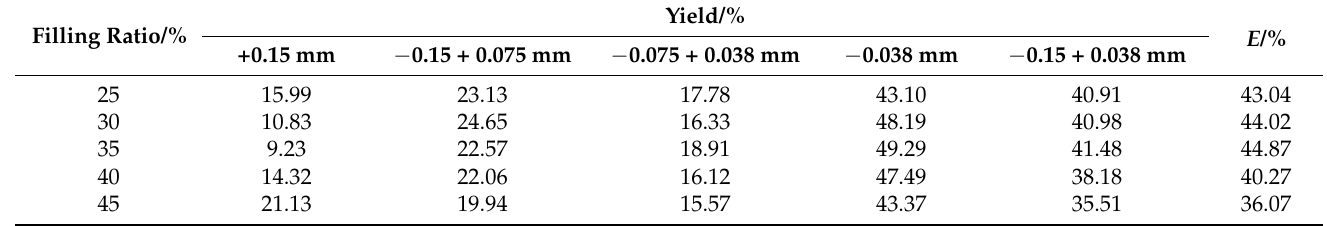
Table 6. Particle size composition of grinding product at different filling ratios.